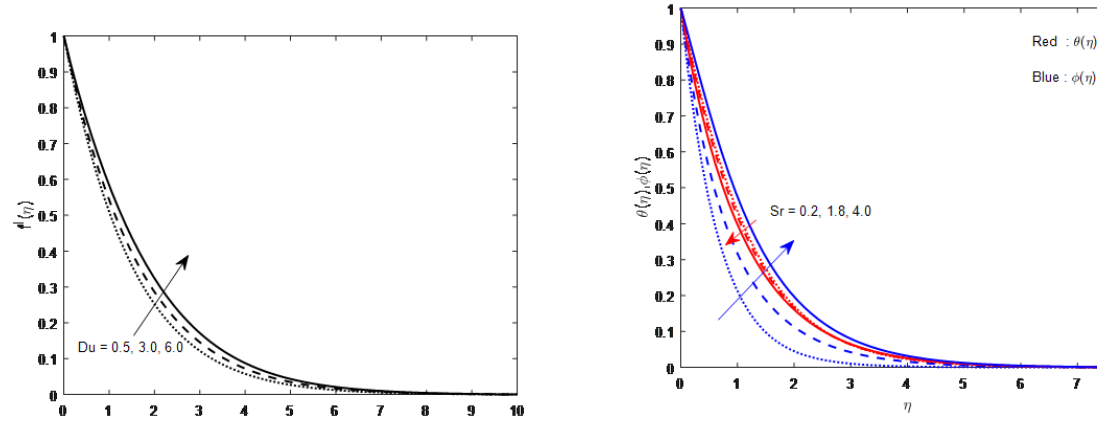
Figure 7: Temperature and concentration profiles for different val- ues of Soret number Sr